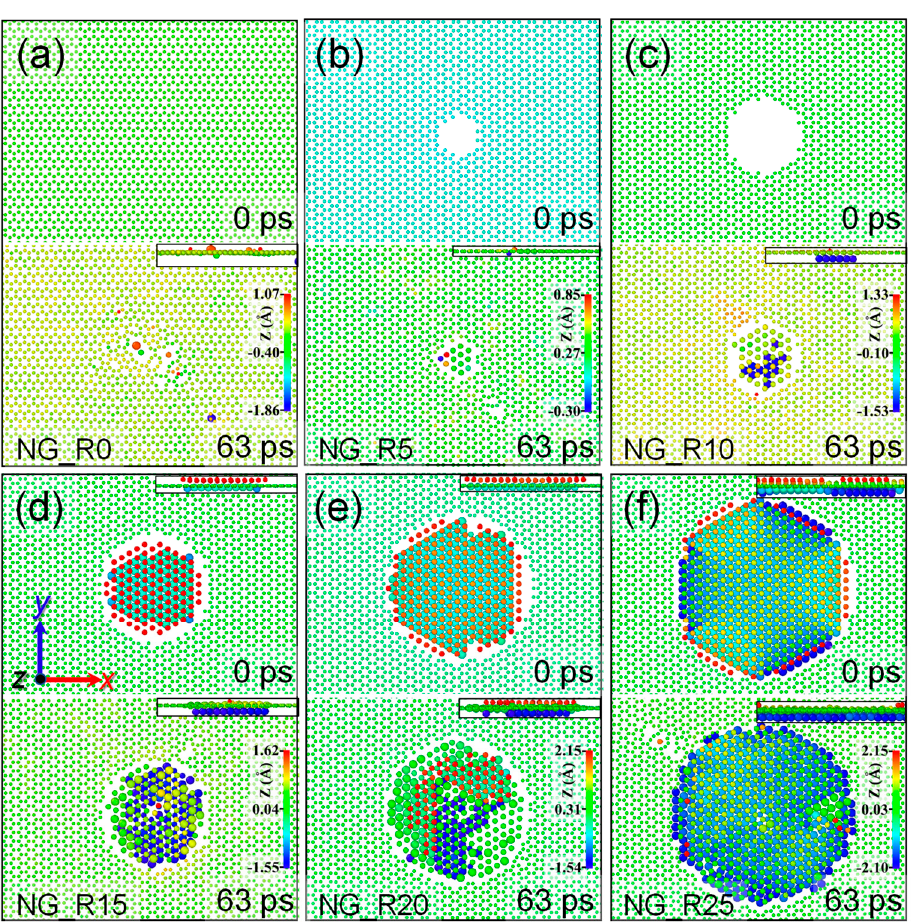
Figure 3. C atoms around the intrinsic hole of each NGI model and the corresponding Ni atoms in the channels between Ni and Gr. ( a ) NG_R0. ( b ) NG_R5. ( c ) NG_R10. ( d ) NG_R15. ( e ) NG_R20. ( f ) NG_R25. Each panel contains the atomic configurations of the beginning (0 ps) and ending (63 ps) moments of cascades. Atoms are colored according to the z-coordinate starting at Gr. The smallest spheres represent C atoms, and the rest denote Ni atoms.